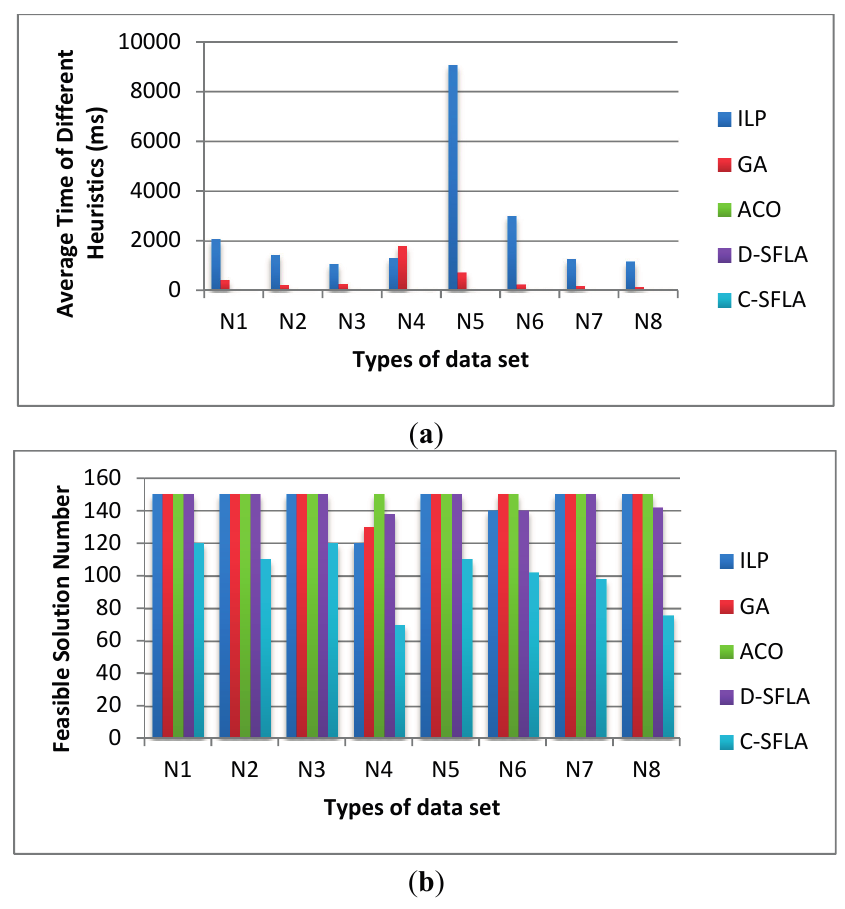
Figure 8. The average runtime and feasible solution numbers of for ILP, GA, ACO, D-SFLA and C-SFLA algorithms: ( a ) average time; and ( b ) feasible solution